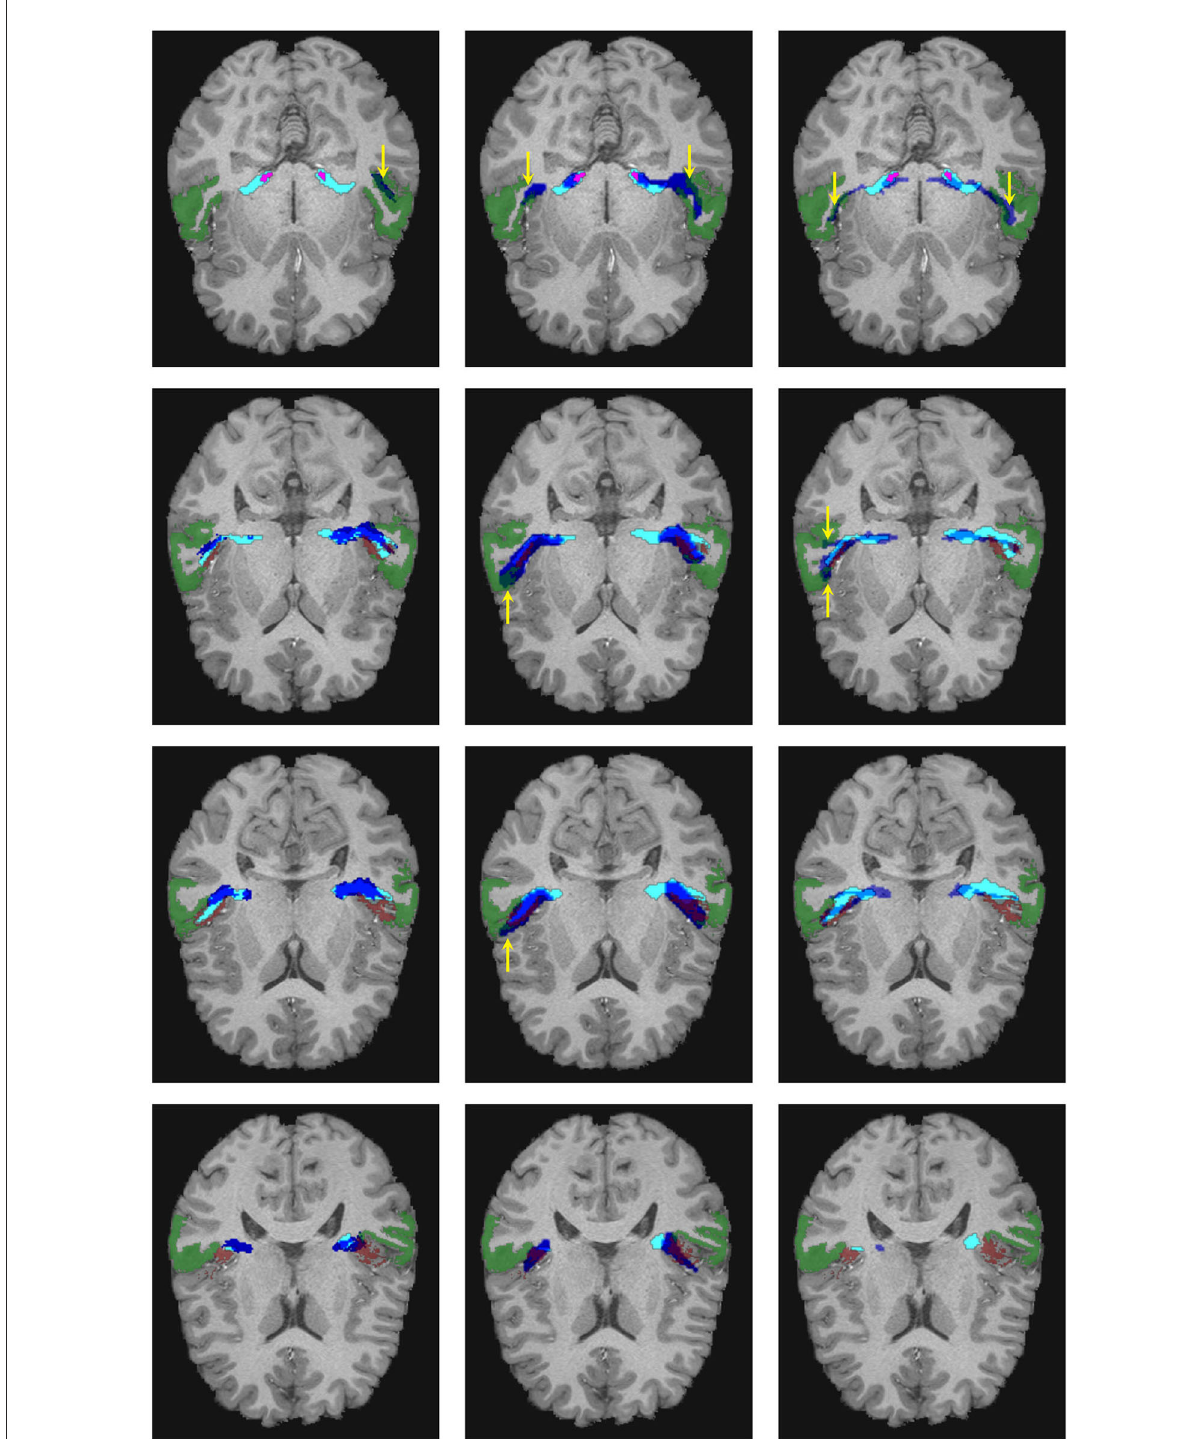
FIGURE6 Visual comparison of the segmentation masks in one subject of the human connectome project. First column: Segmentation mask of the proposed methodology (in cyan) and the atlas by Maffei et al. (16) (in blue). Second column: Segmentation mask of the proposed methodology (in cyan) and the atlas by Bürgel et al. (2) (in blue). Third column: Segmentation mask of the proposed methodology (in cyan) vs. the result from XTRACT (in blue). Every row corresponds to a different axial slice. The superior temporal gyrus (STG), medial geniculate nucleus, and Heschl’s gyrus are depicted in green, magenta, and brown, respectively. Yellow arrows indicate where the segmentation masks reach the